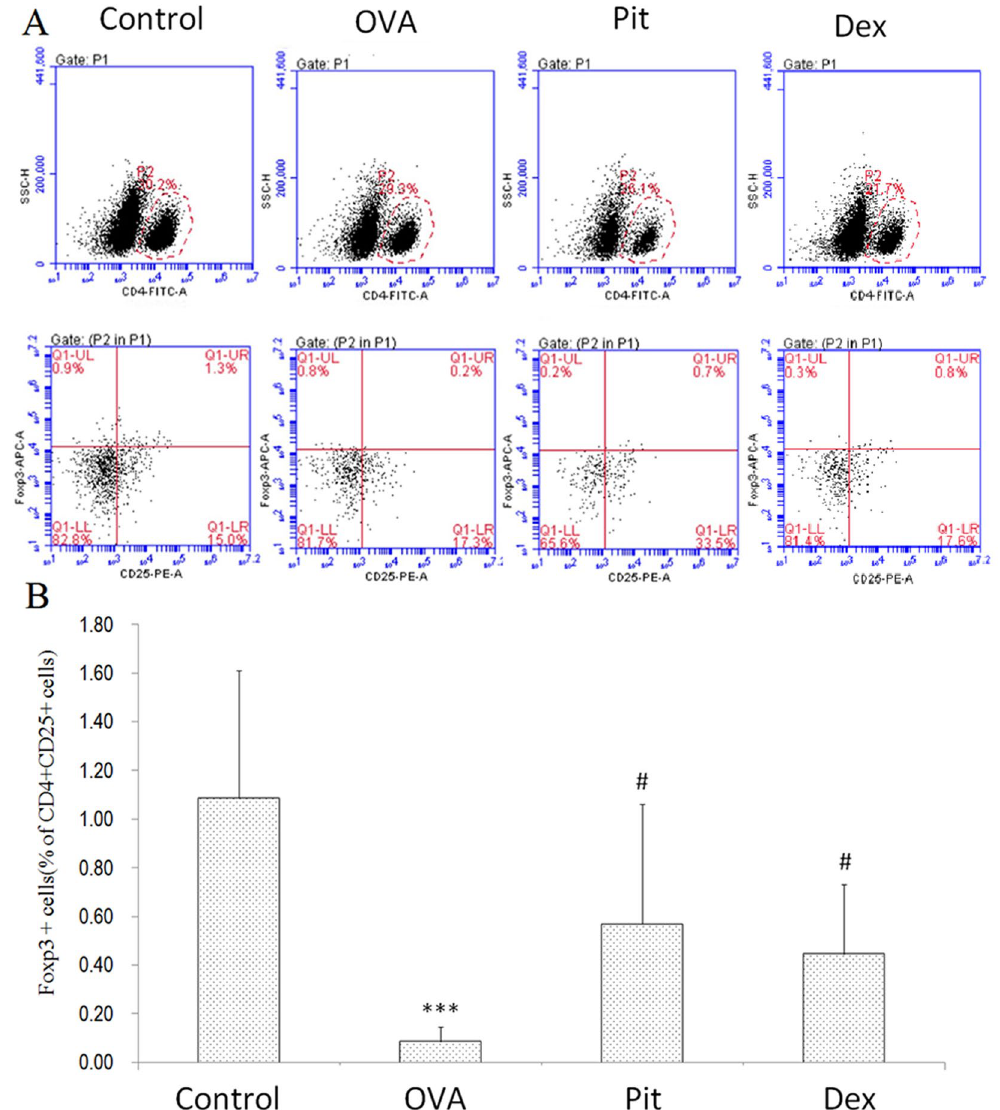
Figure 3. Pitavastatin treatment increases the numbers of CD4 + CD25 + Foxp3 + cells in BALF. Cell suspensions were isolated from the BALF of mice in the control, OVA-challenged, pitavastatin-treated, and dexamethasone-treated groups. The cells were stained with labelled antibodies specific for CD4, CD25, and FoxP3. ( A ) Representative flow cytometry plots representing the proportions of CD4 + CD25 + and CD25 + FoxP3 + T cells (examined on gated CD4 + cells). ( B ) Relative proportion of CD4 + CD25 + Foxp3 + Treg cells. The results represent the mean ± SD (n = 6–8). Control: Lung sections from mice treated with aerosolized PBS. OVA: Lung sections from mice challenged with OVA and treated with PBS. Pit and Dex: Lung sections from mice challenged with OVA and treated with pitavastatin and dexamethasone, respectively. ** P < 0.01 compared with the control group; # P < 0.05 compared with the OVA